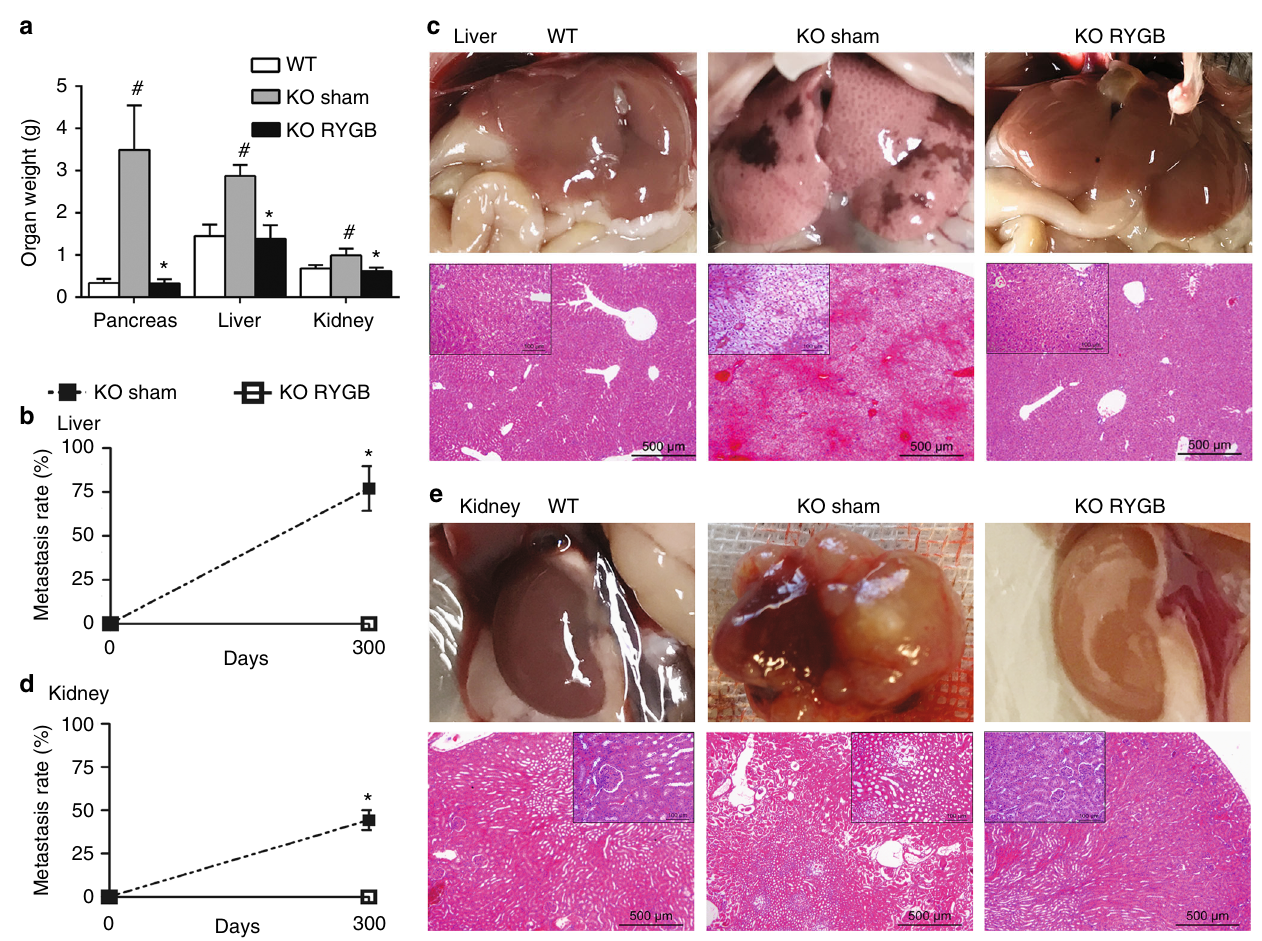
Fig. 2 RYGB surgery effectively prevents the metastasis of pancreatic ACC. a Weight of pancreas, liver, and kidney. # P < 0.05 vs. WT. * P < 0.05 vs. Ngn3- Tsc1 − / − (KO) sham. b Liver metastasis rate (left). c Liver gross and histological (H&E) morphology (right) in Ngn3-Tsc1 − / − (KO) mice with sham or RYGB surgery. d Kidney metastasis rate (left). e Kidney gross and histological (H&E) morphology (right) in Ngn3-Tsc1 − / − (KO) mice with sham or RYGB surgery. Values are mean ± SEM. n = 9, 5, 5 for WT sham, Ngn3-Tsc1 − / − (KO) sham, Ngn3-Tsc1 − / − (KO) RYGB, respectively, for male mice. n = 8, 5, 4 for WT sham, Ngn3-Tsc1 − / − (KO) sham, Ngn3-Tsc1 − / − (KO) RYGB, respectively, for female mice. Statistical differences were analyzed by one-way ANOVA followed by the Student ’ s t -test. * P < 0.05 vs. Ngn3-Tsc1 − / − (KO)